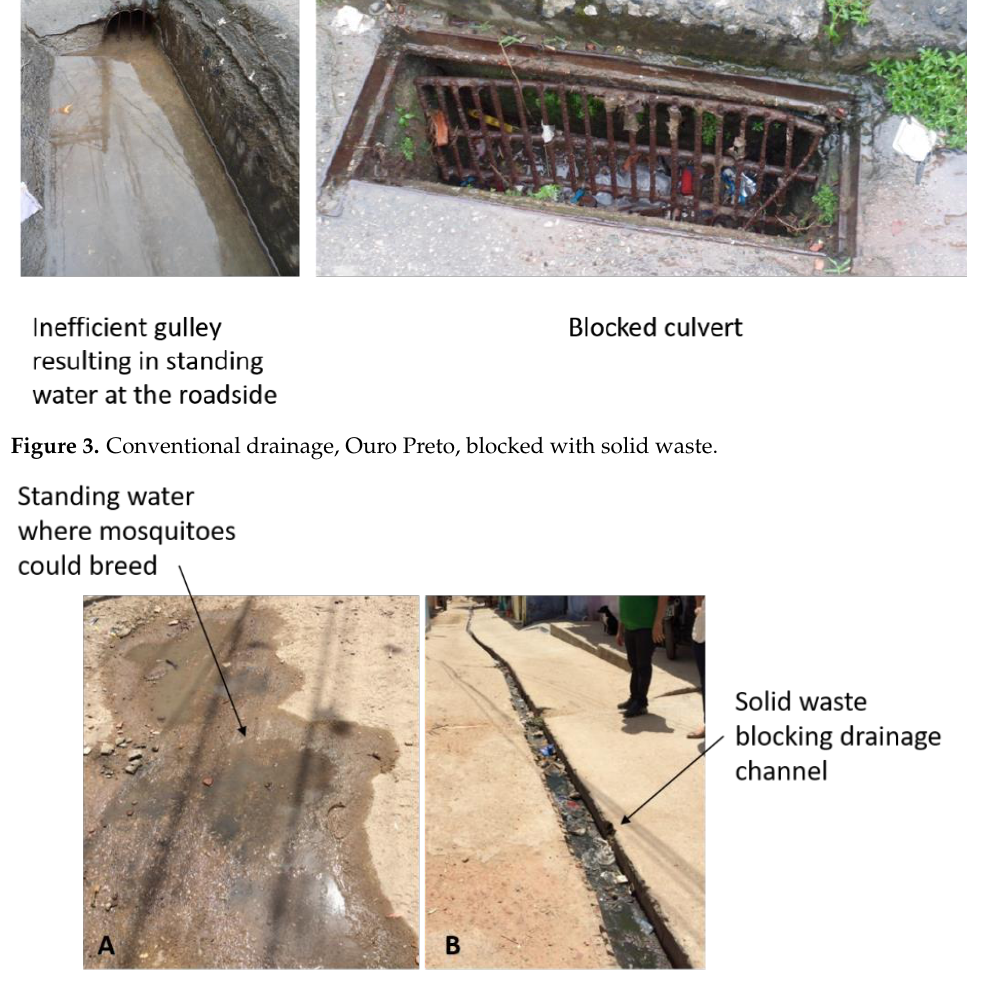
Figure 4. ( A , B ) Blocked and inadequate drainage, with mosquito larvae in standing water outside dwellings in favelas, Fortaleza, Brazil. dwellings in favelas, Fortaleza,